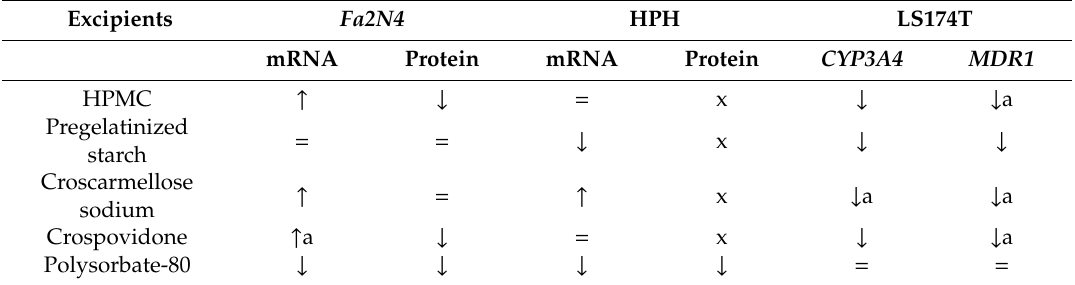
Table 7. E ff ect of excipients on PXR activation, CYP3A4 and MDR1 .